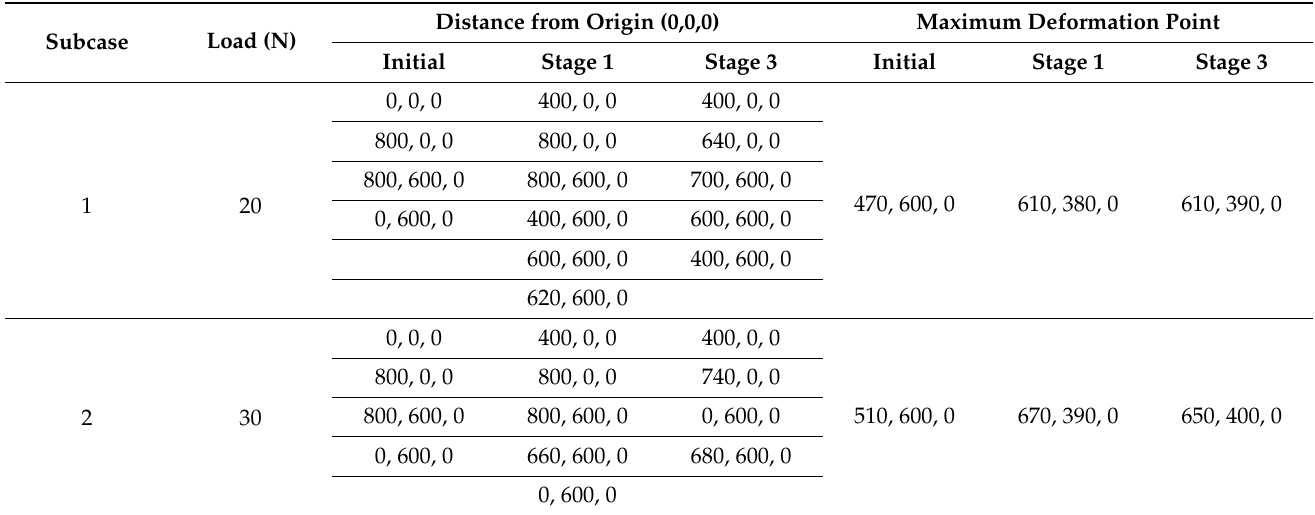
Table 3. Coordinates of clamp positions and maximum deformation point case study 1—flat plate.